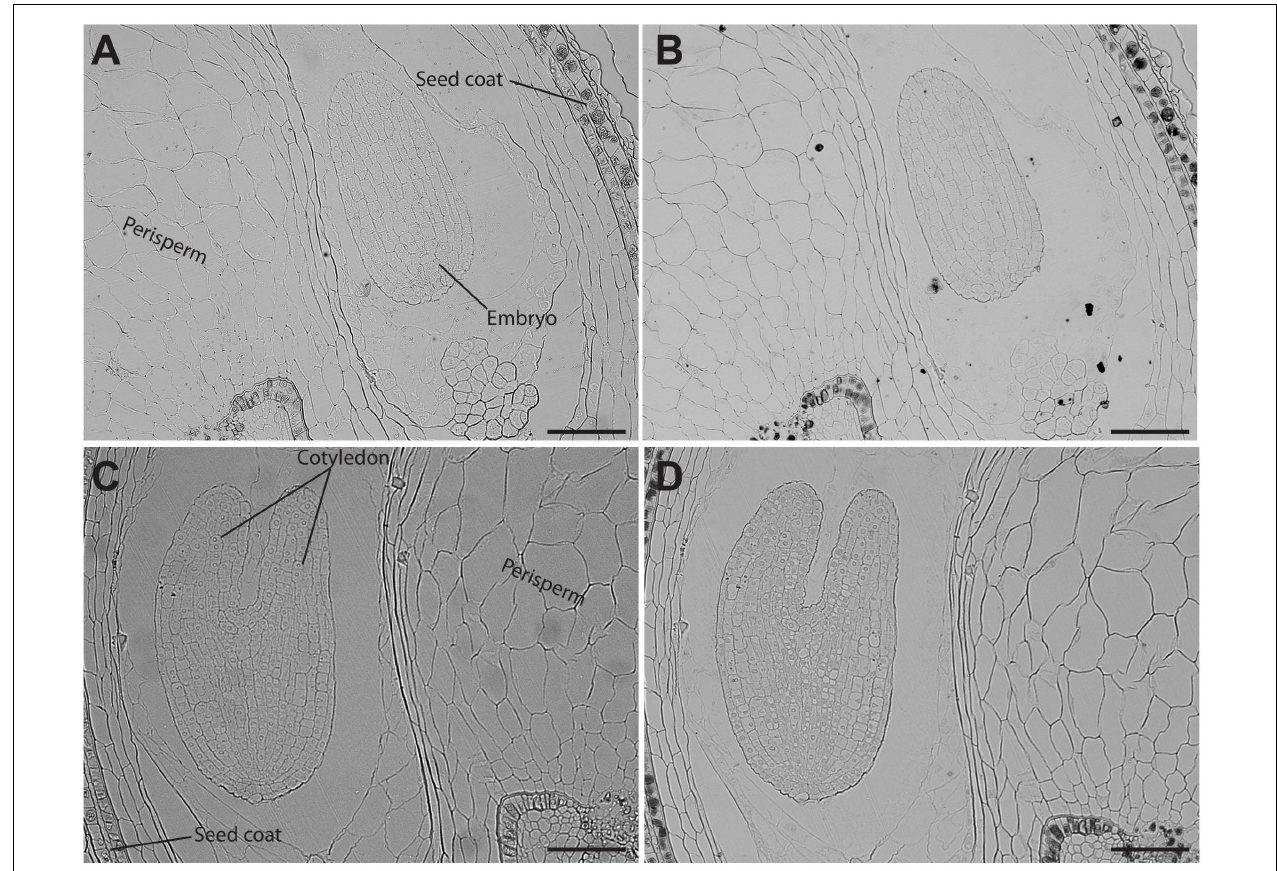
FIGURE 4 | Iron distribution in C. quinoa seeds in early developmental stages. C. quinoa seeds 3 and 7 days postanthesis were collected from fruits, embedded in Technovit resin, sectioned (3 µ m) and then stained with Perls/DAB (B , D) . Unstained sections were used as control (A , C) . The scale bar represents 100 µ